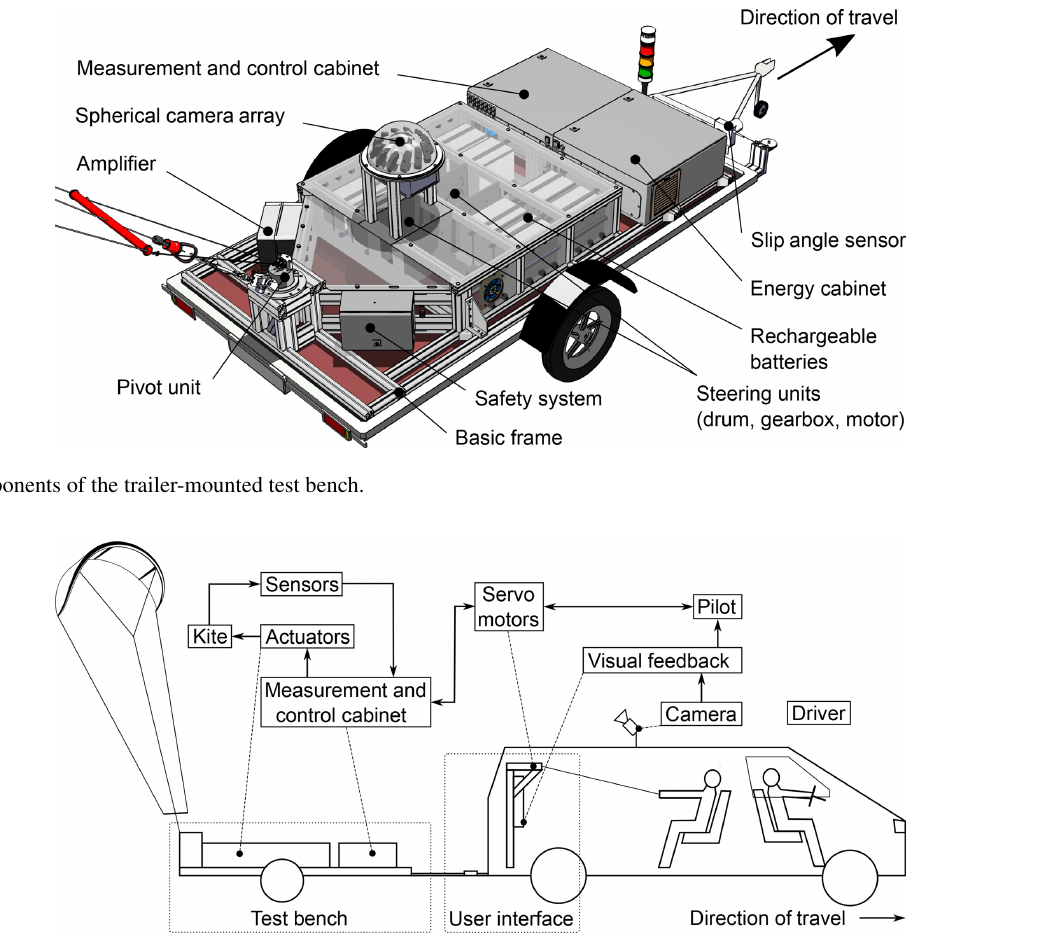
Figure 6. Towing test